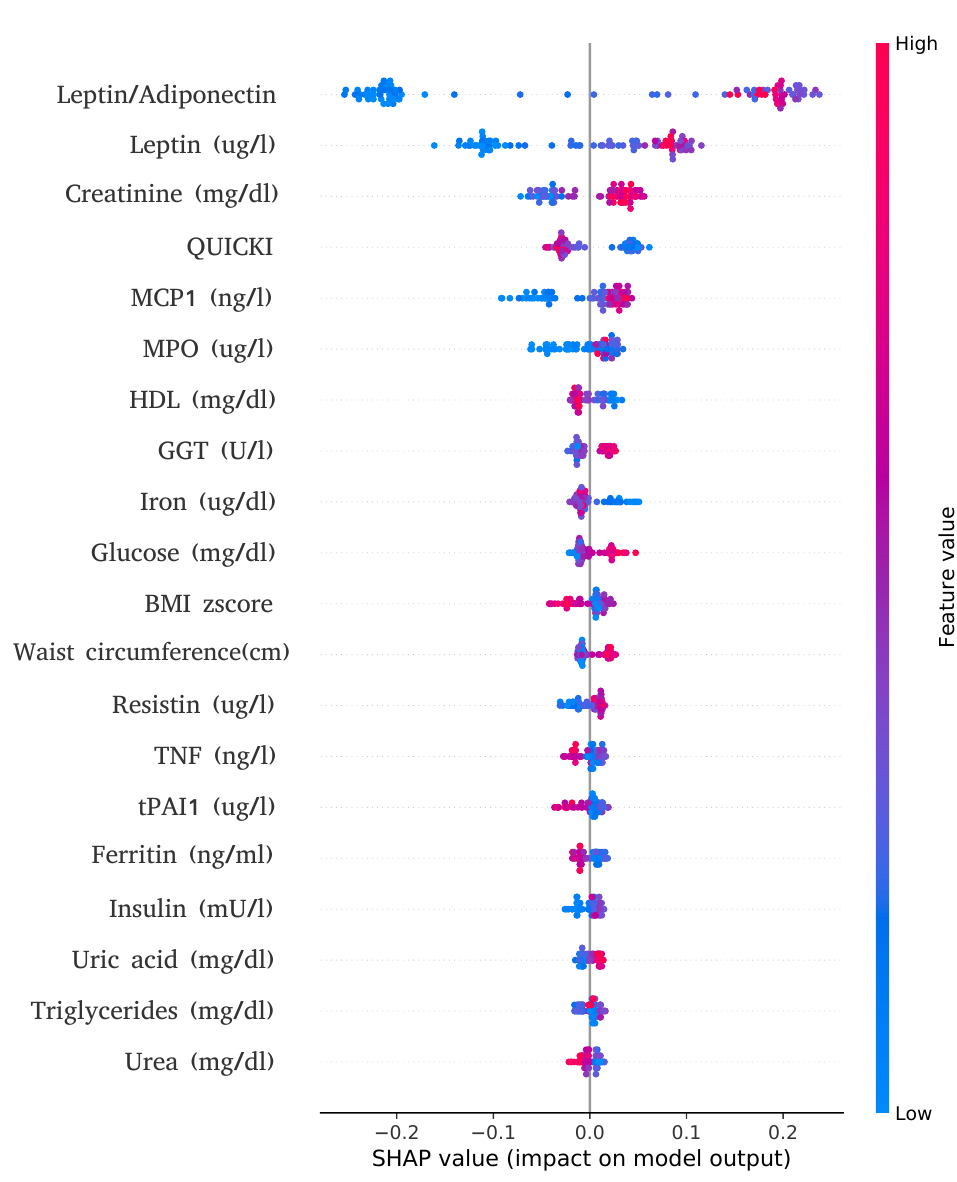
Figure 3. SHAP dot plot. The 20 most important attributes of the biochemistry datasets are displayed according to their overall importance. Each dot represents the value of a sample for a given attribute, and its SHAP value is its contribution to the model’s output for a specific sample. Dot colors indicate if the value of the sample for the attribute is high (red) or low (blue).